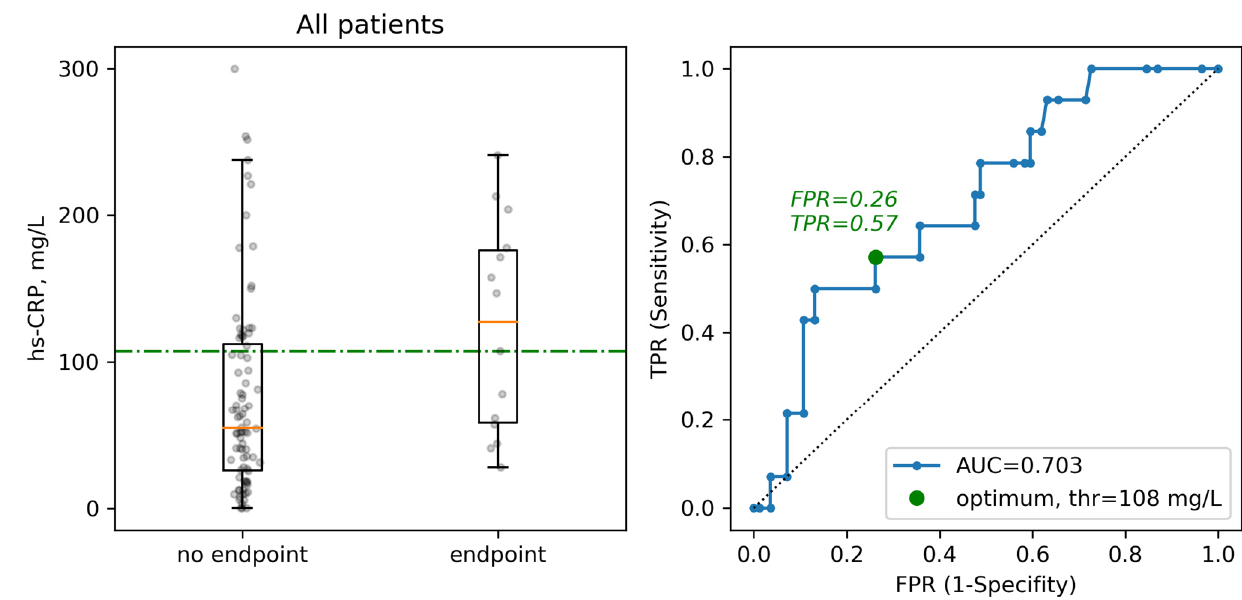
Figure 5. Boxplots and ROC curves for selecting optimal concentration threshold of hs-CRP for defining clinical endpoints.